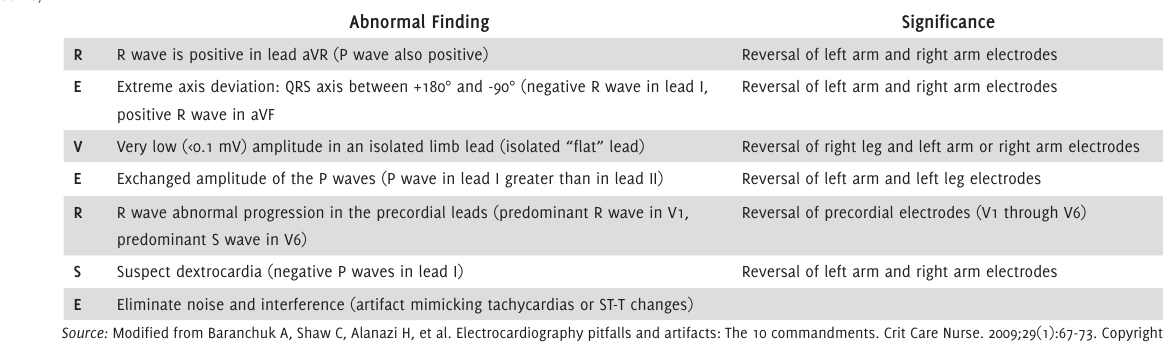
Source: Modified from Baranchuk A, Shaw C, Alanazi H, et al. Electrocardiography pitfalls and artifacts: The 10 commandments. Crit Care Nurse. 2009;29(1):67-73.